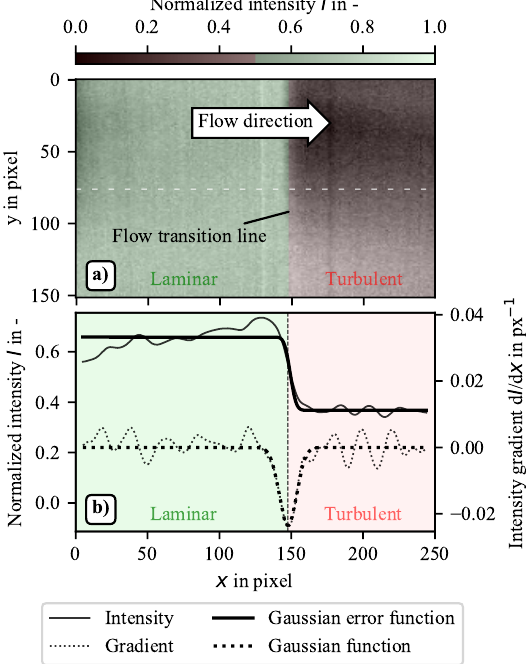
Figure 1. ( a ) Flow visualization image with a laminar and turbulent flow regime distinguishable by different intensity levels. ( b ) Intensity profile (thin black line) and intensity gradient profile (thin black dotted) along the white dashed line in ( a ). Two distinct intensity plateaus corresponding to the laminar and turbulent flow regime are visible with a steep change between them. A Gaussian error function fitted to the intensity profile is shown with a thick black line, and a Gaussian function fitted to the corresponding gradient profile is shown with a thick black dotted line. The laminar- turbulent flow transition can be localized by the saddle point of the Gaussian error function and by the maximum of the Gaussian